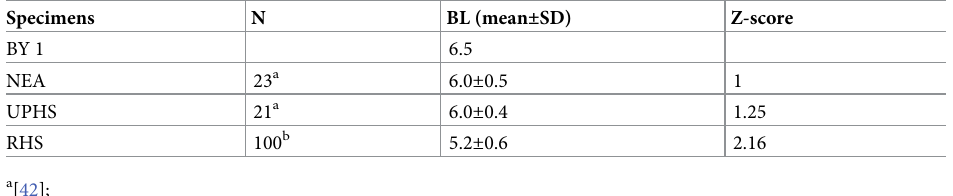
Table 1. Buccolingual (BL) crown diameter of BY1, compared to mean values of Neanderthal (NEA), early Homo sapiens (EHS) and recent Homo sapiens (RHS) lower deciduous